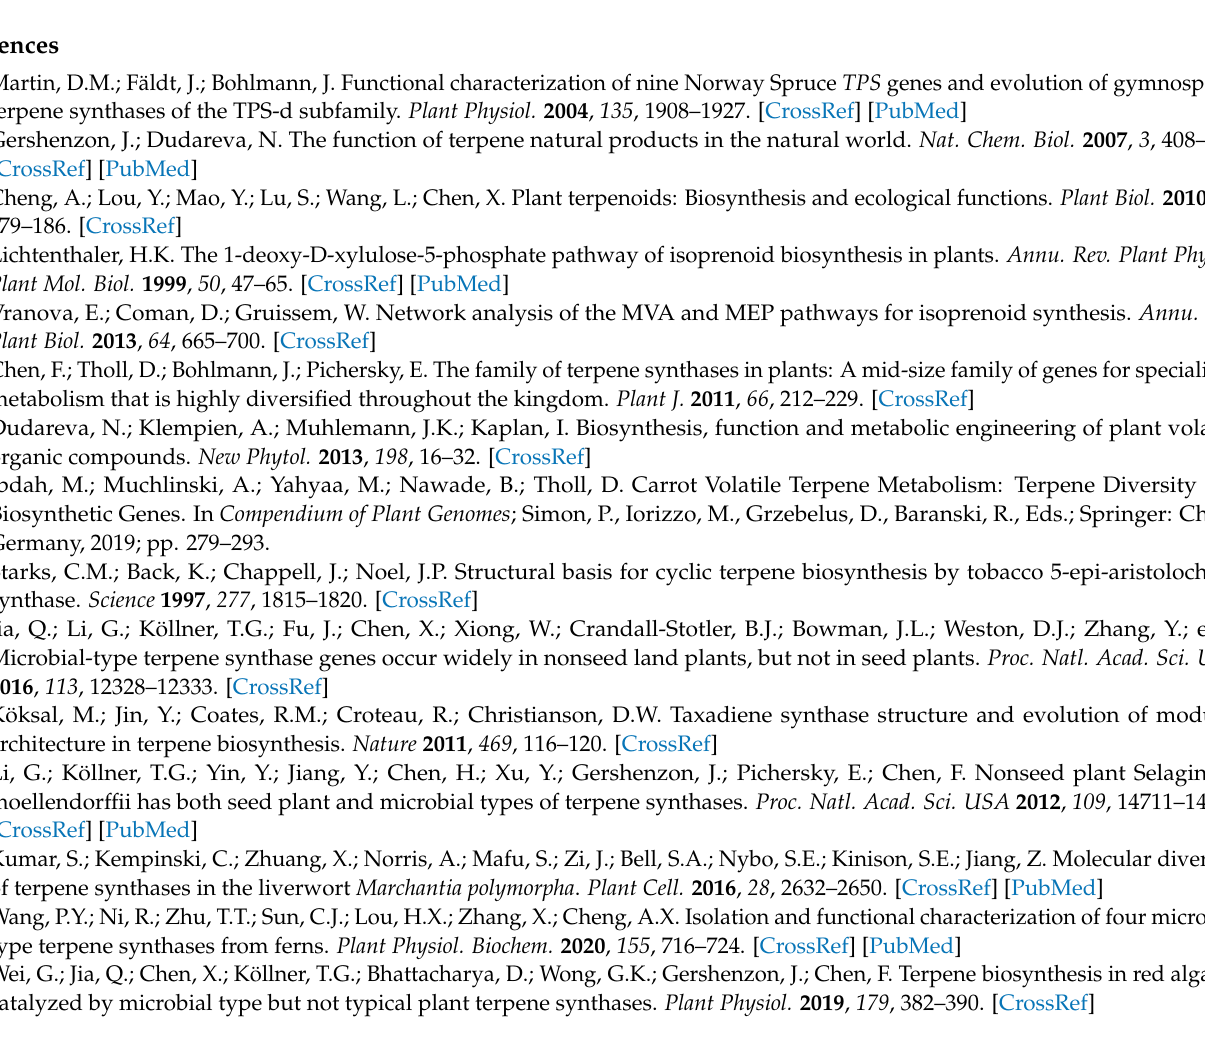
Table S3: Primers used in this study; Figure S1: Phylogenetic tree of TPSs sequences; Figures S2–S8: Structure model and molecular docking analysis of SmMTPSL5, -15, -23, -33, -37, -46, and -47. Author Contributions: G.L. (Guanglin Li), Y.Z., T.H., and R.L. planned the experiments; T.H.,